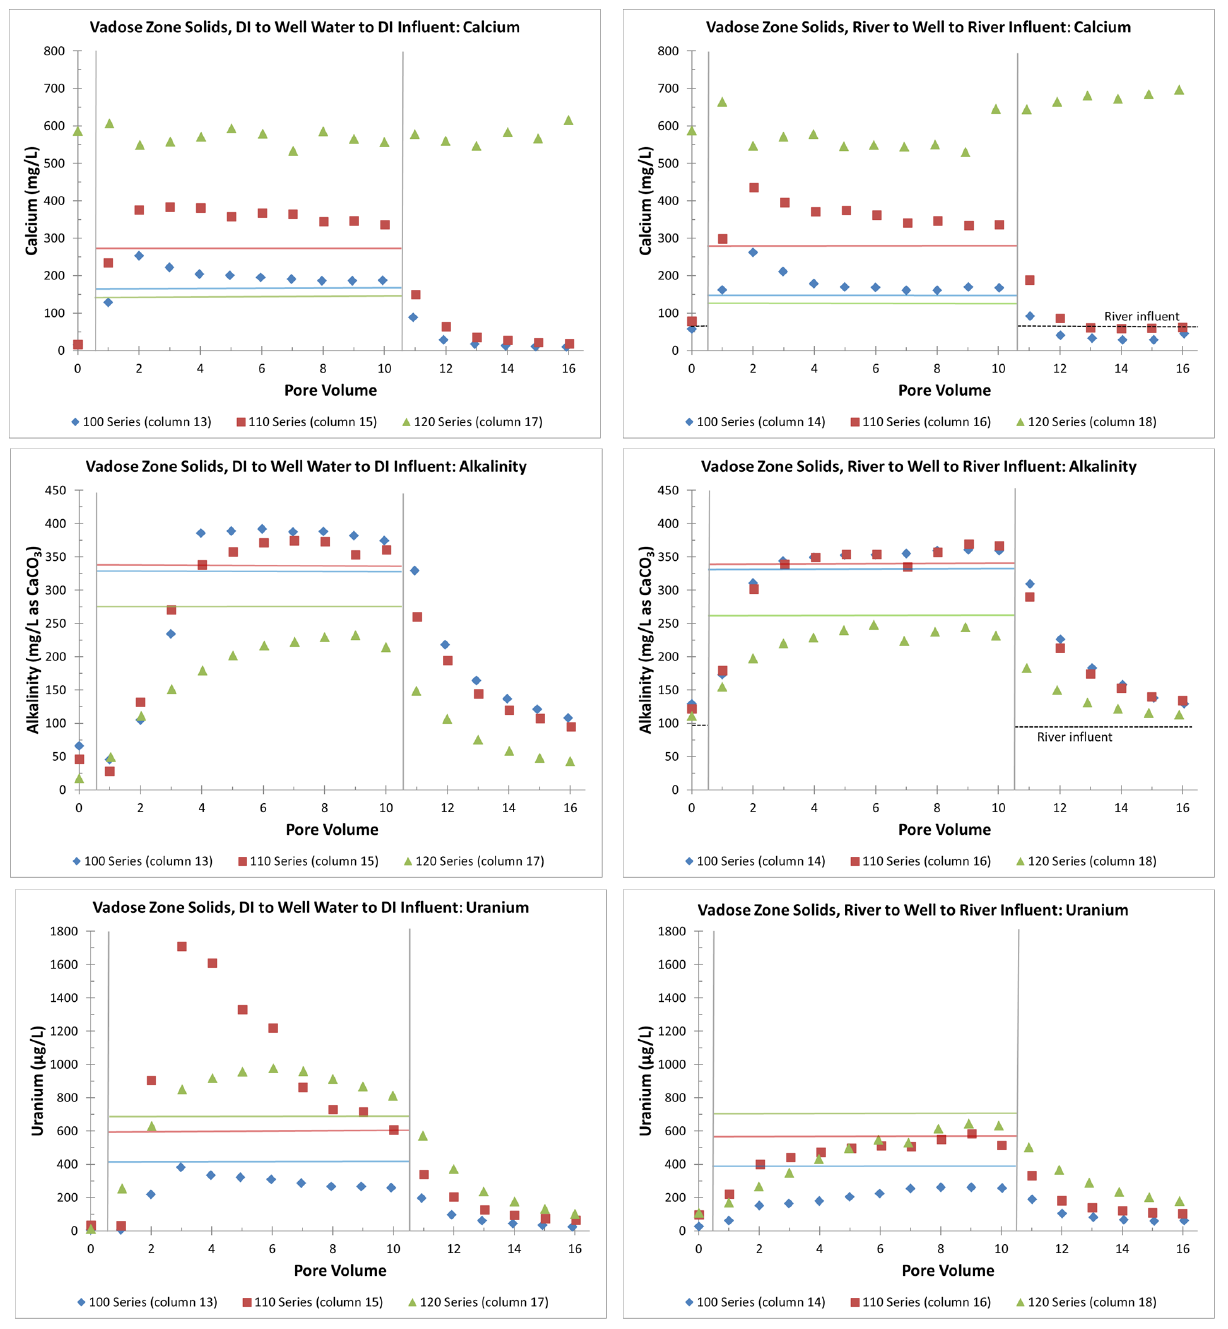
Figure 6. Effluent calcium, alkalinity, and uranium concentrations in VZ columns for PVs after the initial DI or river water influents. The data for PV 0 are the effluent concentrations from DI or river-water influents in the PV just before the switch to a groundwater influent. Colored horizontal lines correspond to the groundwater influent concentrations (blue = well 106, red = well 110, and green = well 120).